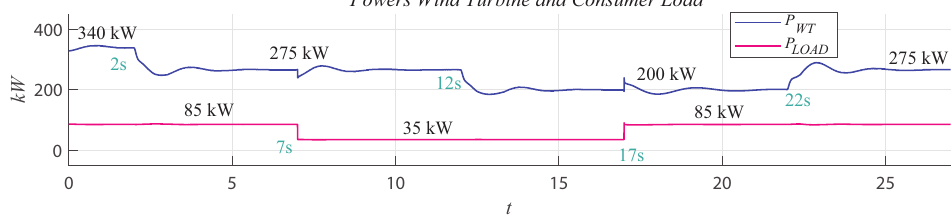
Figure 10. Power wind and consumer load for case study 1.